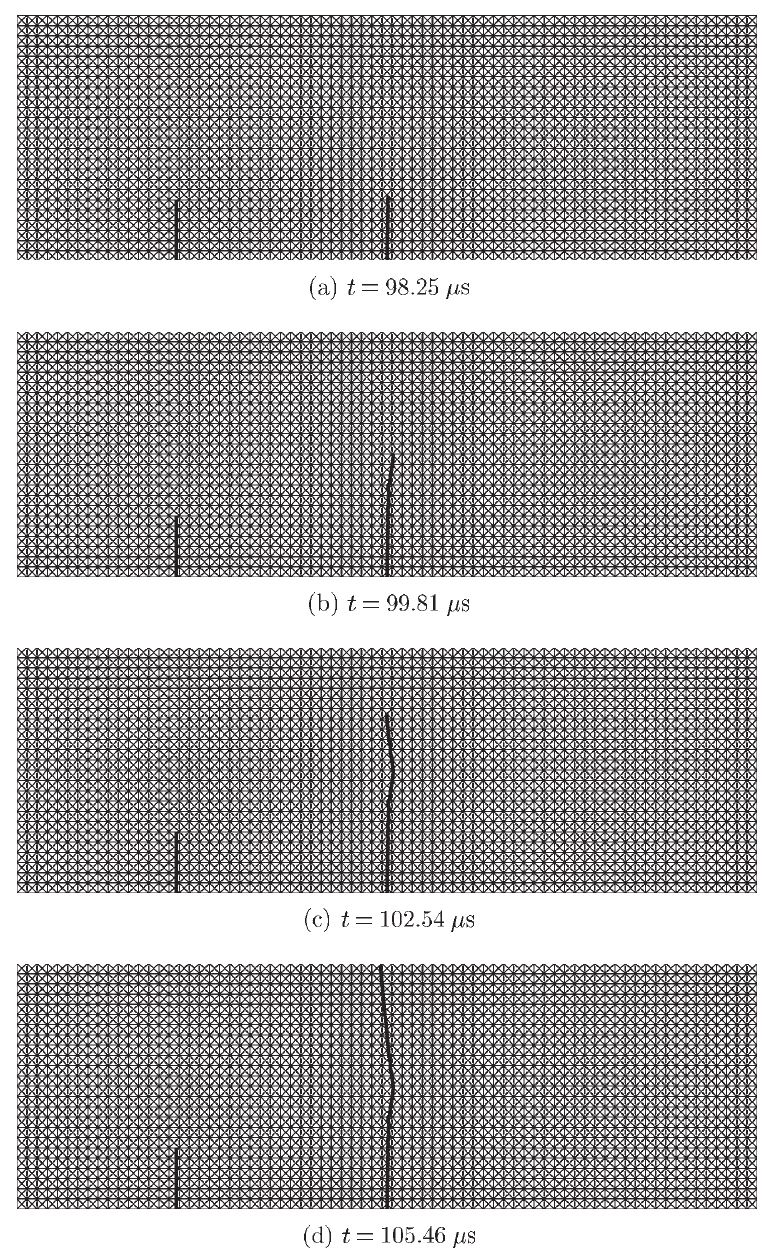
Fig. 10. Crack evolution for 73 × 24 cross-triangular mesh with γ =